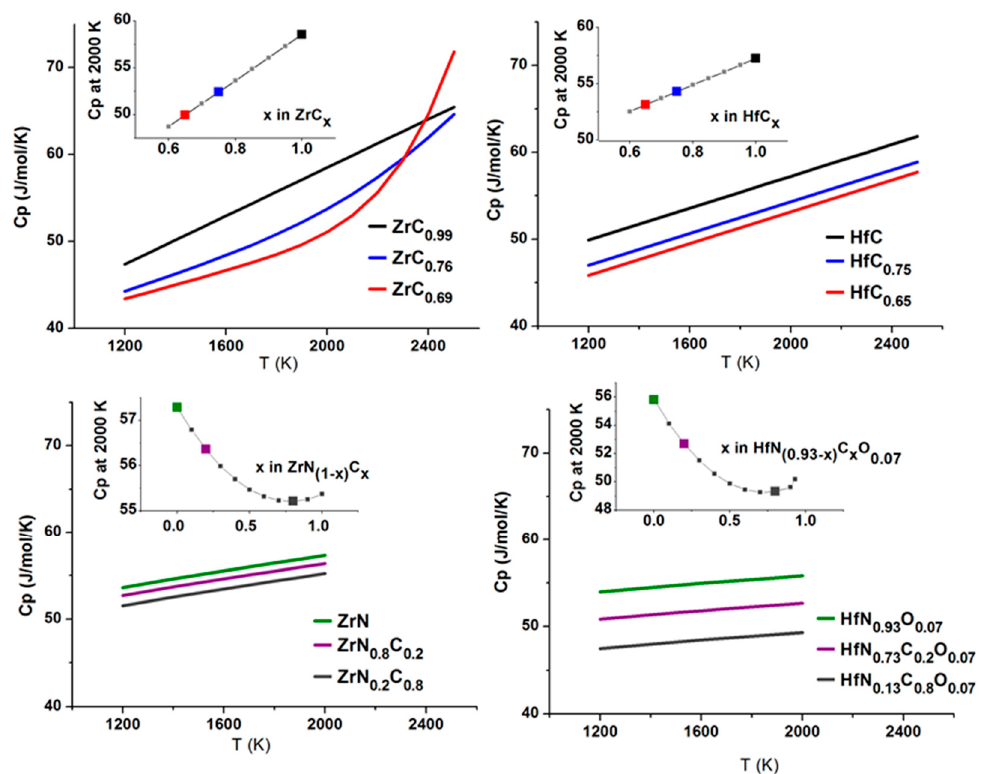
Figure 7. High temperature heat capacity (Cp) of zirconium and hafnium carbides and carbonitrides after Turchanin (1991) [30]. The insets show isotherms of heat capacity at 2000 K versus composition. Temperature dependence for selected compositions is shown on the main graphs. The data are tabulated in supporting information (Tables S6, S7).